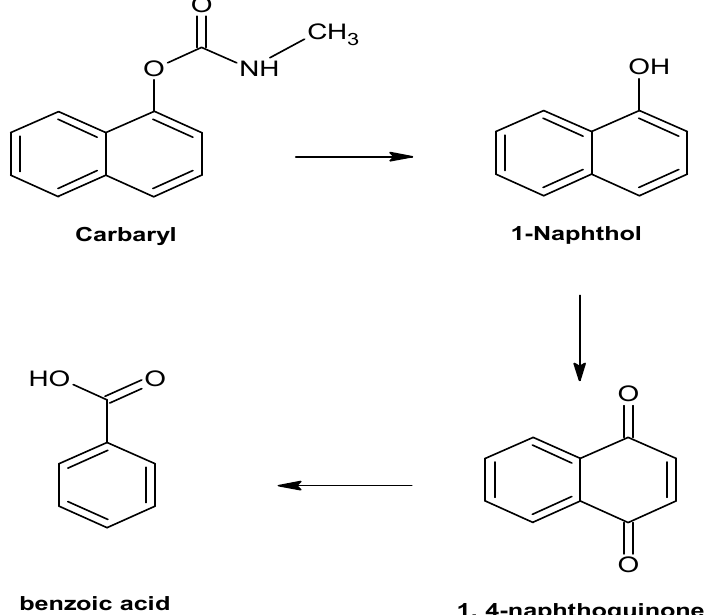
Figure 5. The proposed degradation pathway of carbaryl by Xylaria sp. [224].